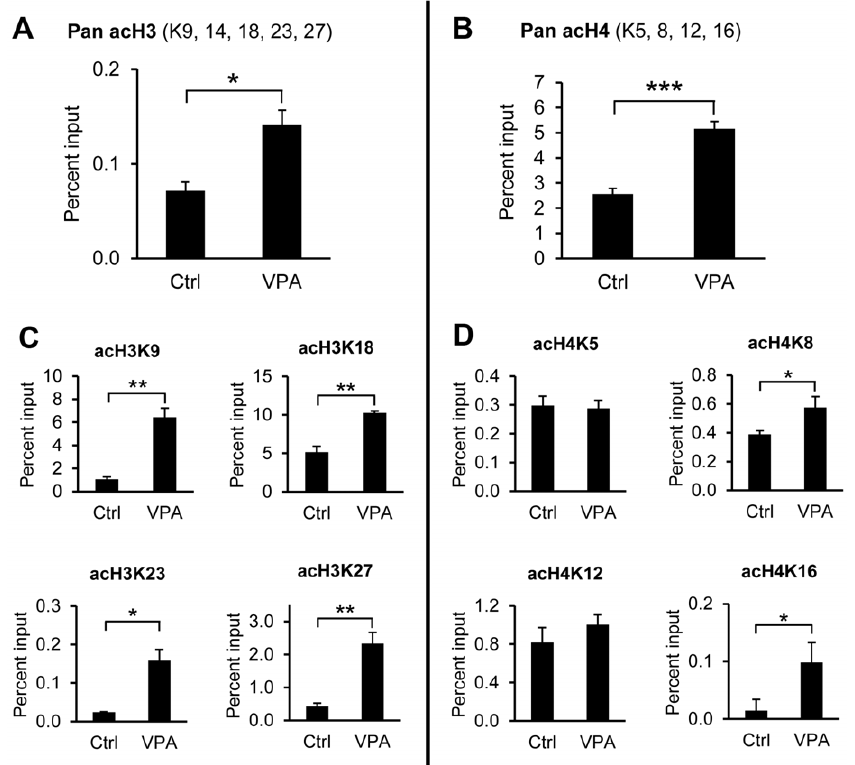
Figure 3. Chromatin Immunoprecipitation (ChIP) for acetylated histones in the t-PA promoter. HUVECs were exposed to 3 mM of VPA for 24 h after which cells were fixed and chromatin harvested. ChIP-analyses for acetylated histone H3 and H4 were performed with real-time PCR primers flanking the major t-PA transcription start site. Data are presented as percent input corrected for background binding and mean values 6 SEM of four to five independent experiments are shown. A. ChIP for pan-acetylated histone H3. n =4. B. ChIP for pan-acetylated H4. n =5. C. ChIP for specific histone H3 acetylation. Antibodies for monoacetylated acH3K9, acH3K18, acH3K23 and acH3K27 were used. n =4. D. ChIP for specific histone H4 acetylation. Antibodies for monoacetylated acH4K5, acH4K8, acH4K12 and acH4K16 were used. n =5. *p , 0.05, **p , 0.01, *** p , 0.001.